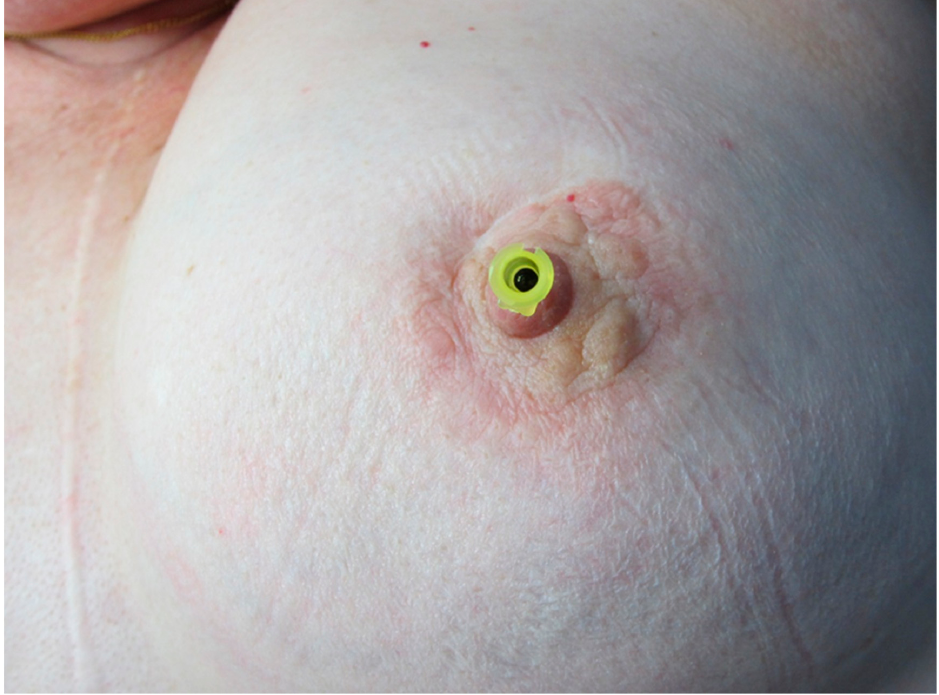
Figure 1. Galactography technique. The picture shows a catheter inserted in the secretory duct.